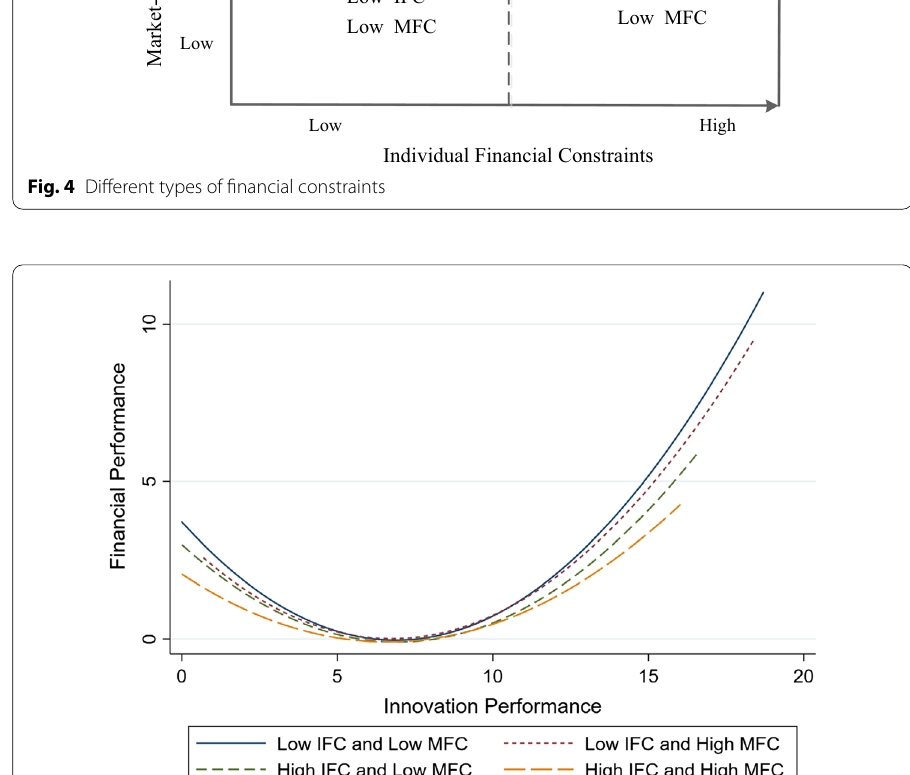
Fig. 5 Relationship between innovation output and financial performance under different levels of financial